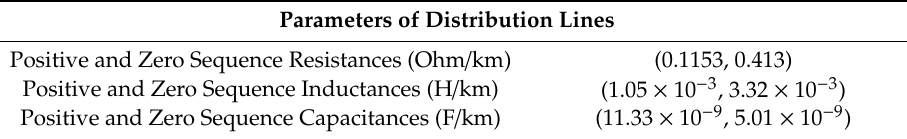
Table A5. Simulation Data for Distribution